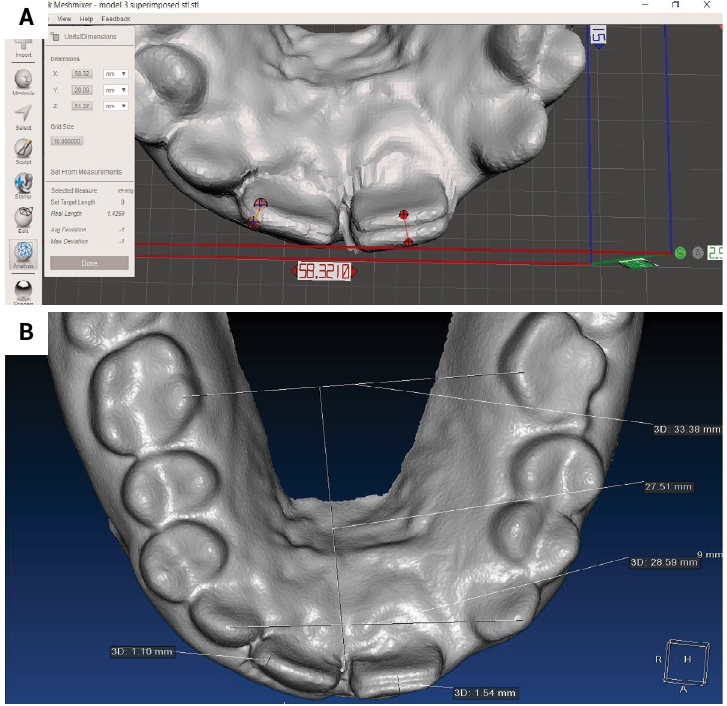
Figure 2. A - Meshmixer measurement of the amount of labial linear transformation of the first tooth and linear transformation of distal contact point of the second tooth; GT1 and GT2. B - The same measurements as in A , but using OrthoAnalyzer; ST1 and